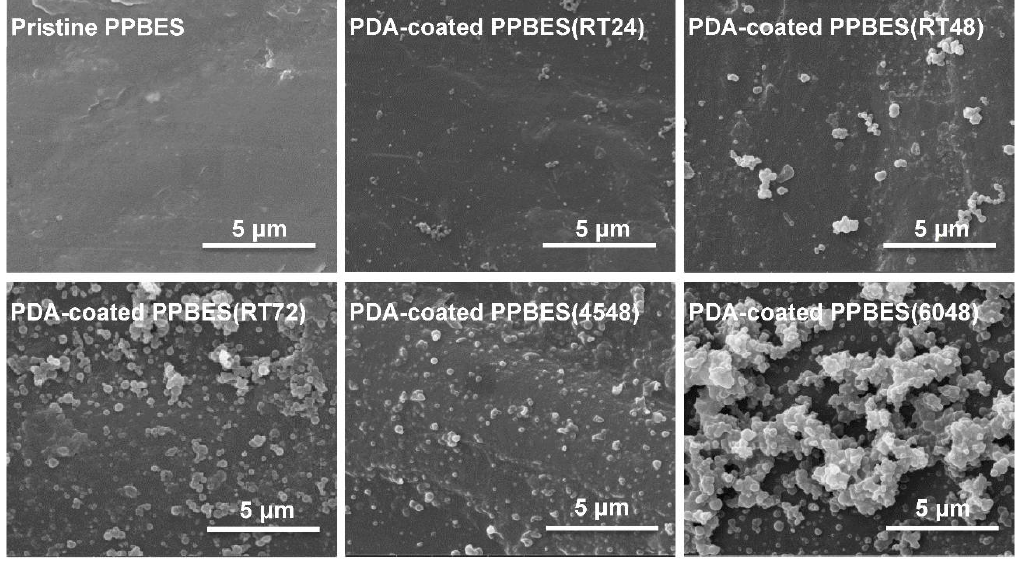
Figure 2. Surface morphology of the polydopamine (PDA)-coated PPBES.